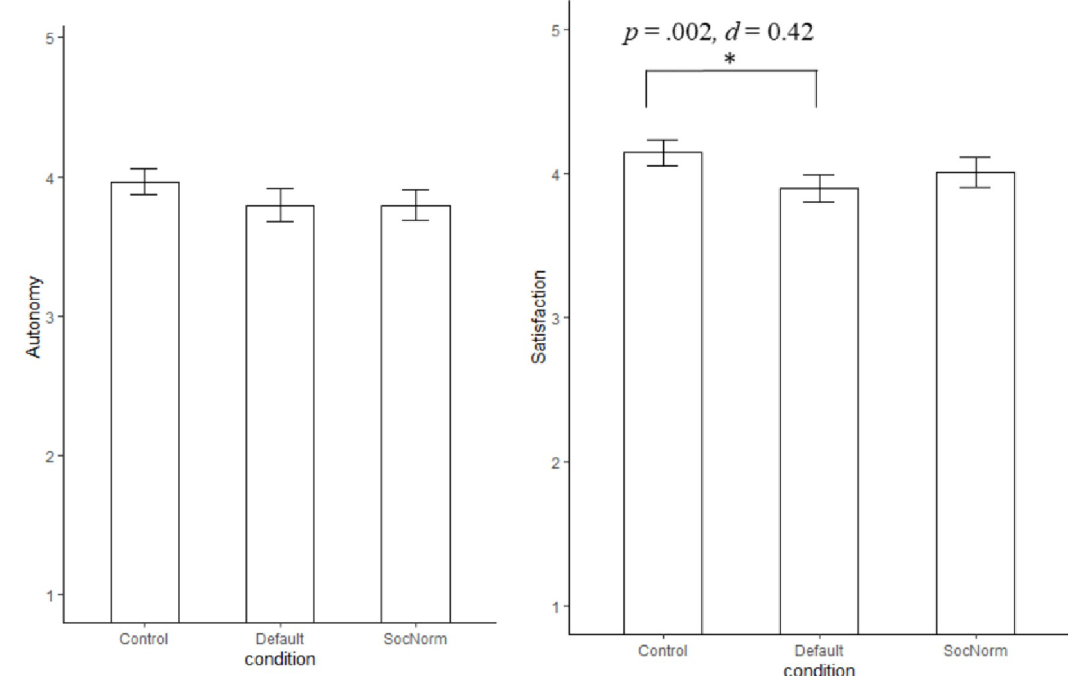
Fig 1. Means and standard errors for autonomy and